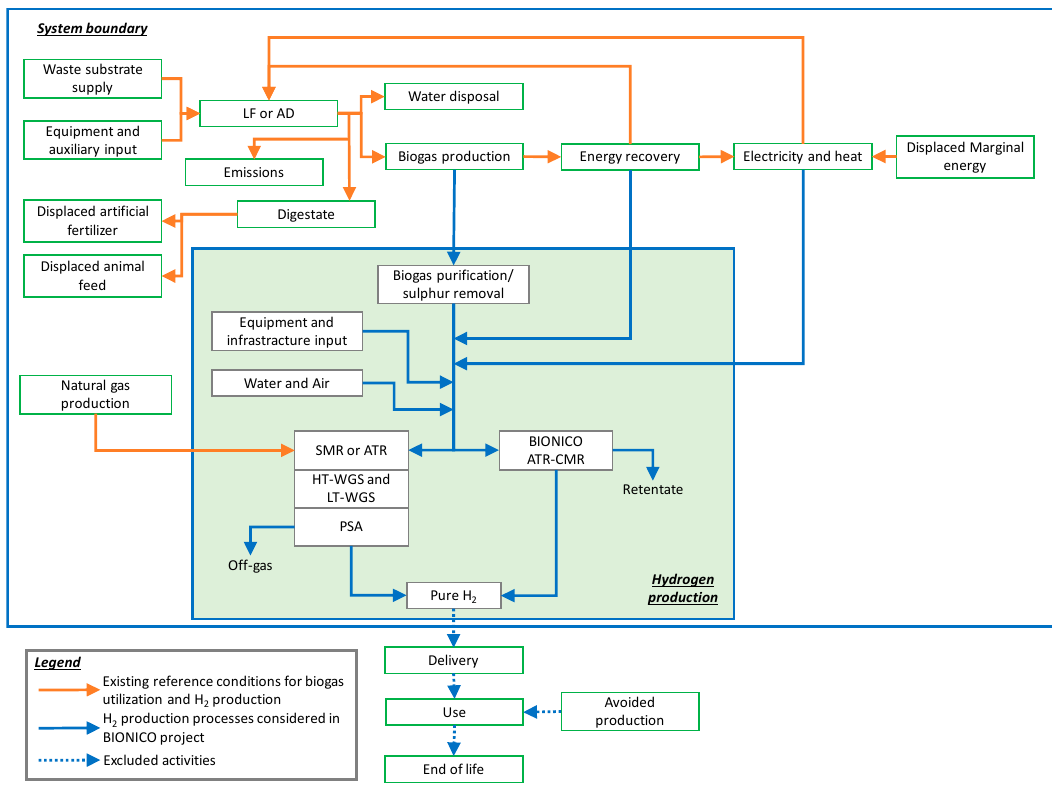
Figure 4. System boundaries for the reference technologies (SMR and ATR) and BIONICO ATR-CMR technology.